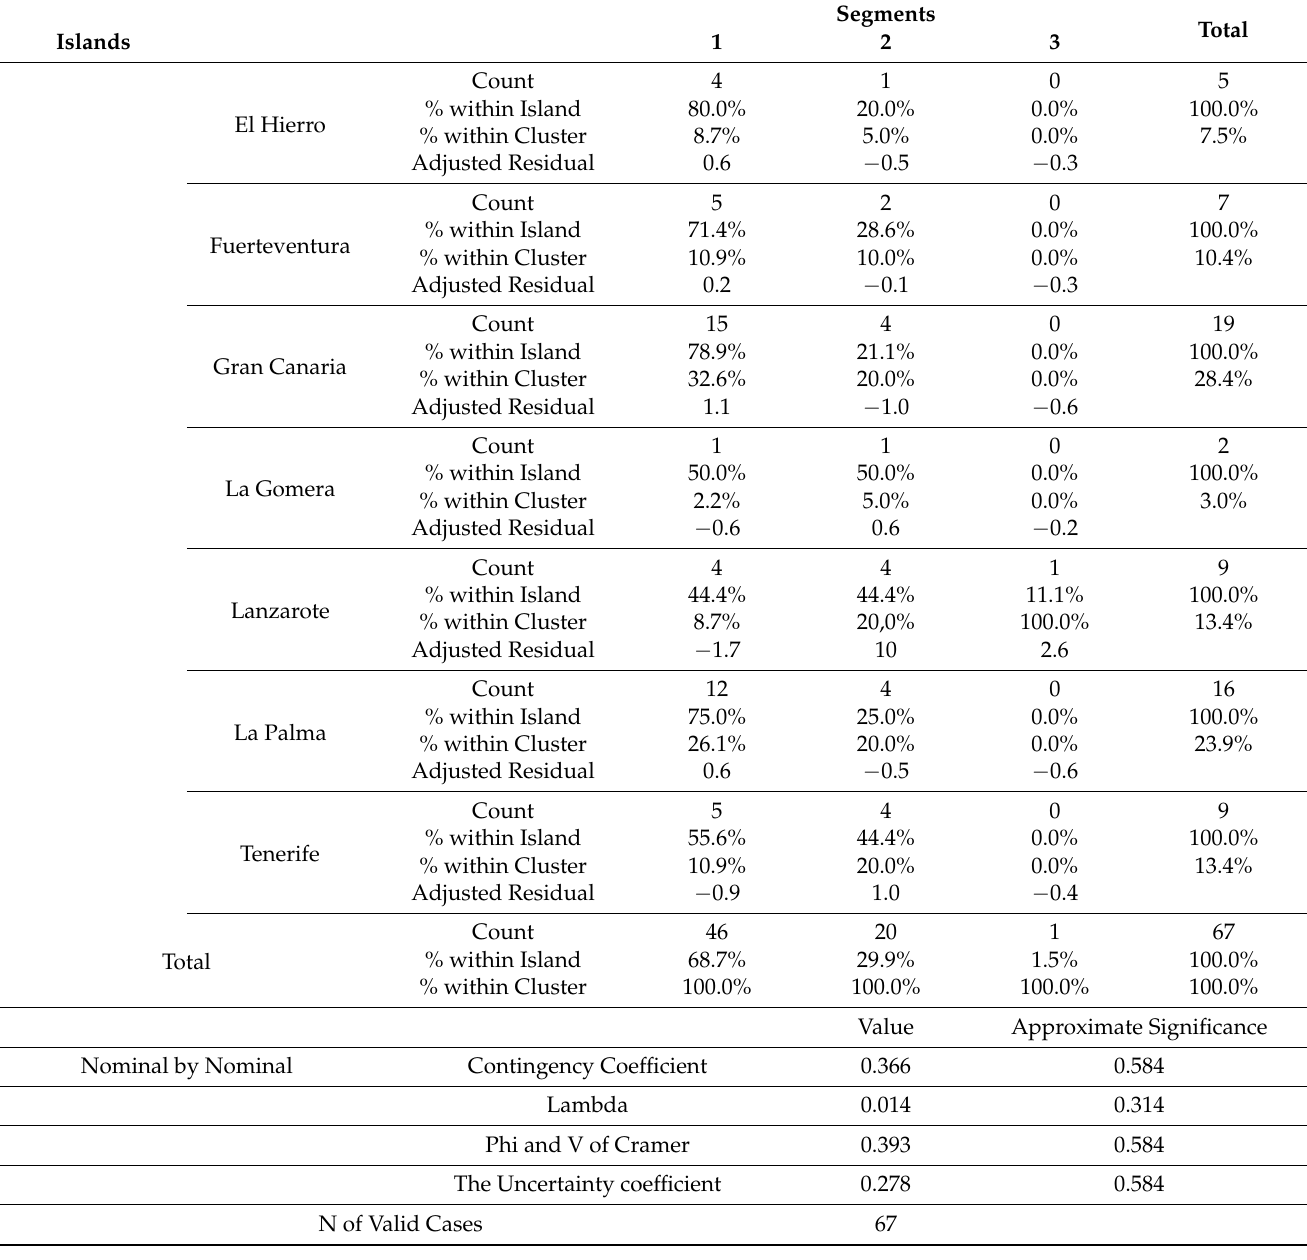
Table 6. Cross-tabulation analysis between the location (island) and the Canary Islands museum websites segment